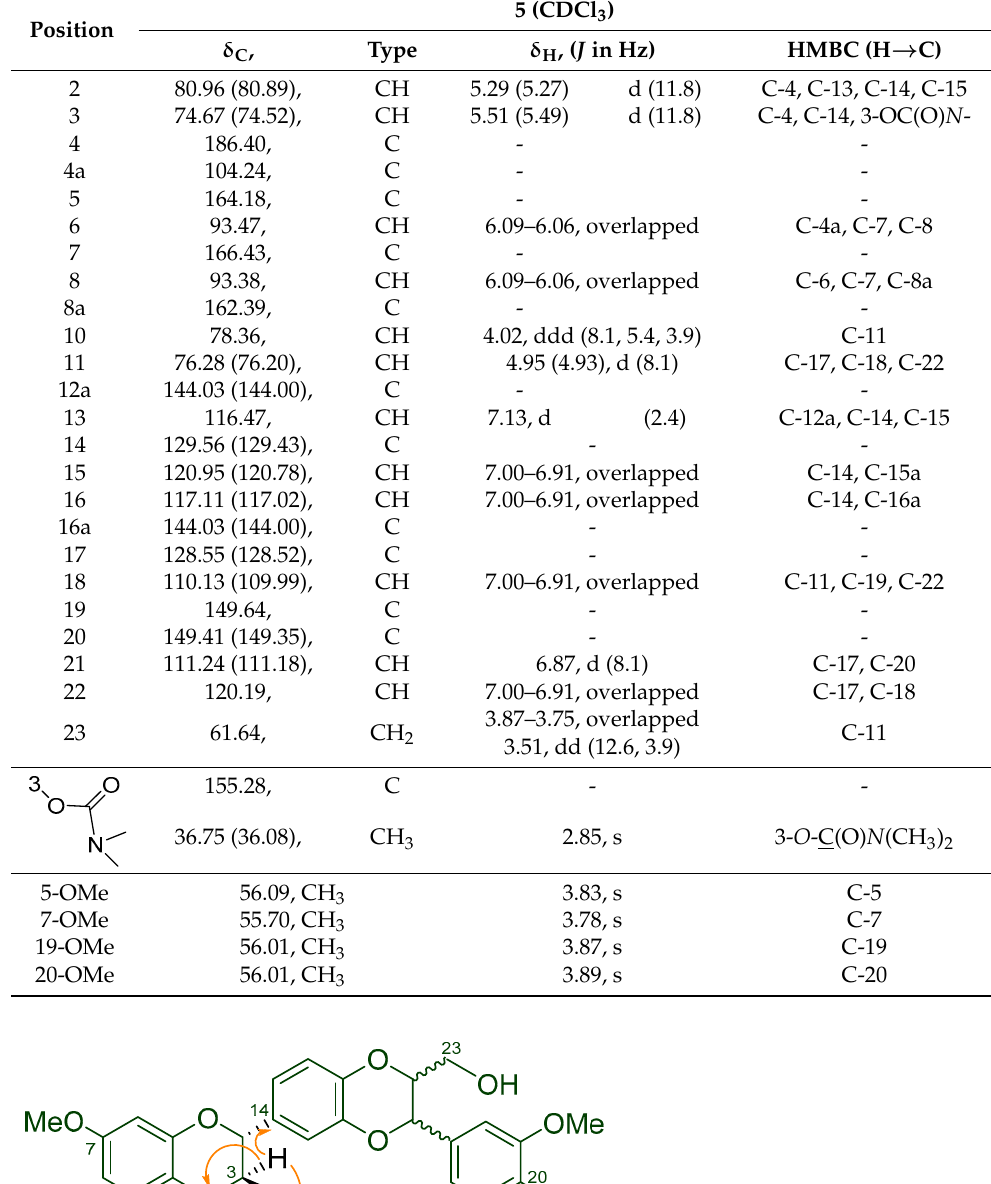
Table 2. NMR data for 5 ( 1 H NMR: 300 MHz; 13 C NMR: 75 MHz).